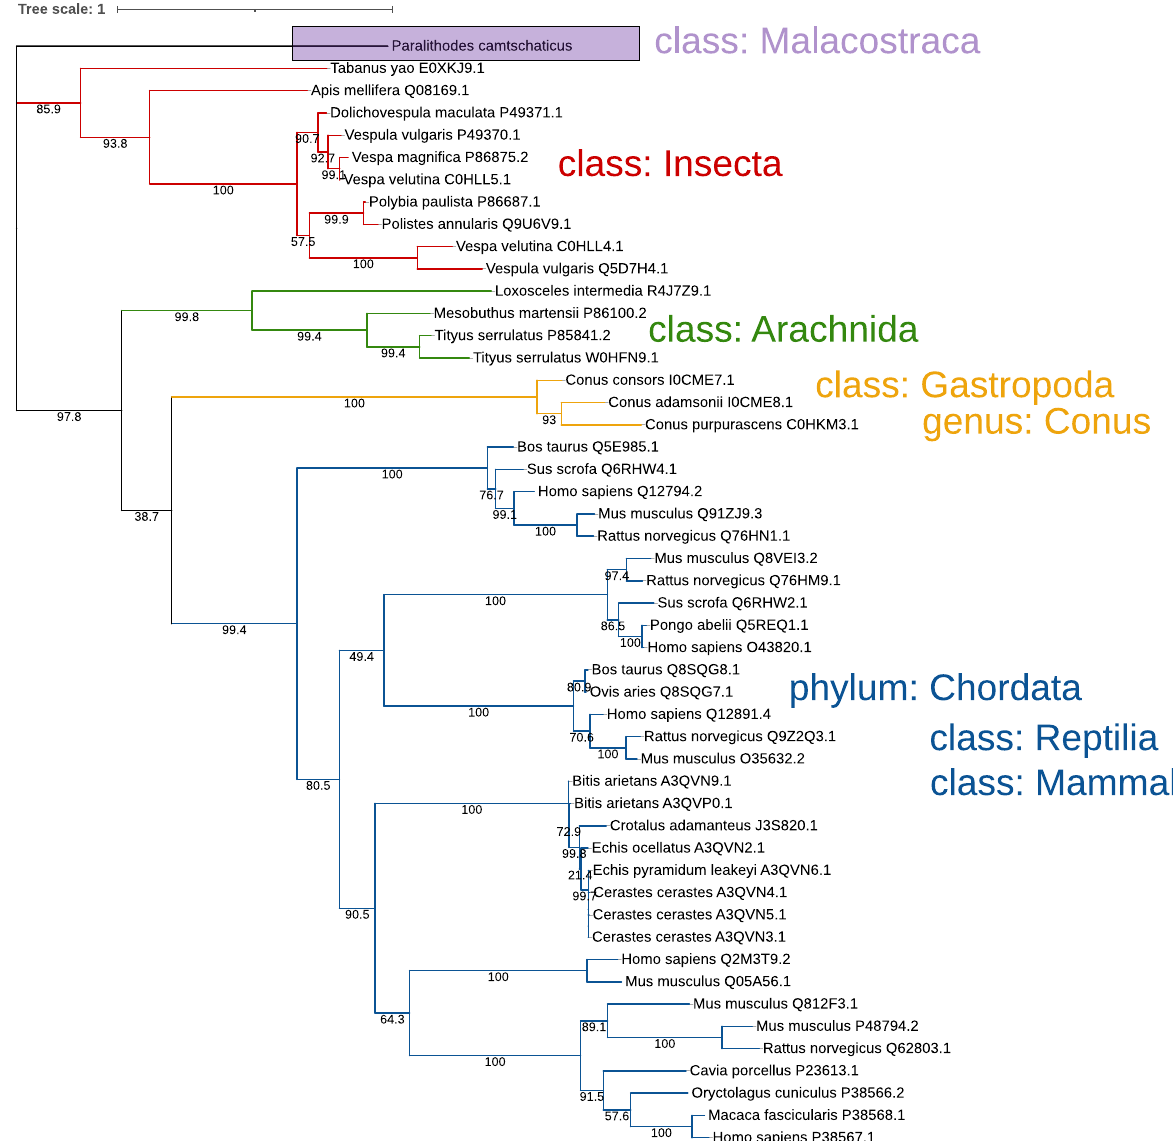
Figure 2. Phylogenetic tree of the homologues of the red king crab hyaluronidase, constructed on the basis of the Swiss-Prot database. Homologues were searched in the Swiss-Prot database using BLASTP with default parameters. A phylogenetic tree was constructed from MUSCLE-aligned sequences of hyaluronidases with the help of IQ-TREE 31 . For visualization, iTOL was used 32 , bootstrap values are indicated at the branch